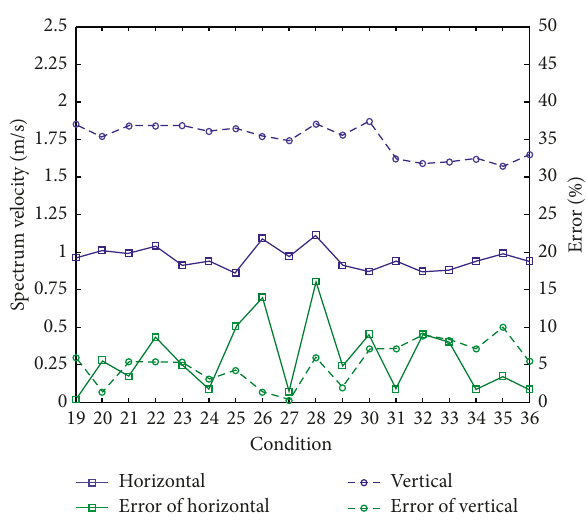
Figure 18: Comparison of the impact response on the port